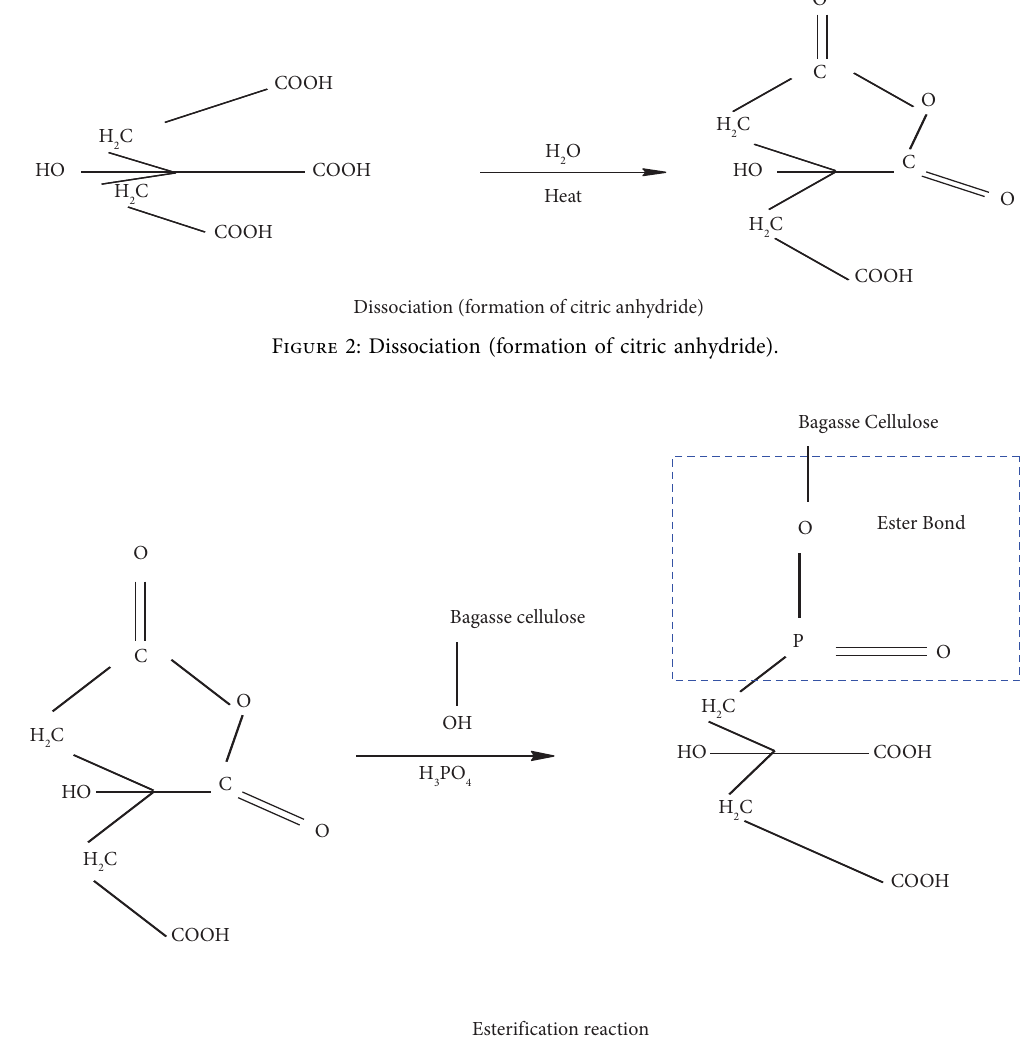
Figure 3: Esterifcation reaction between bagasse